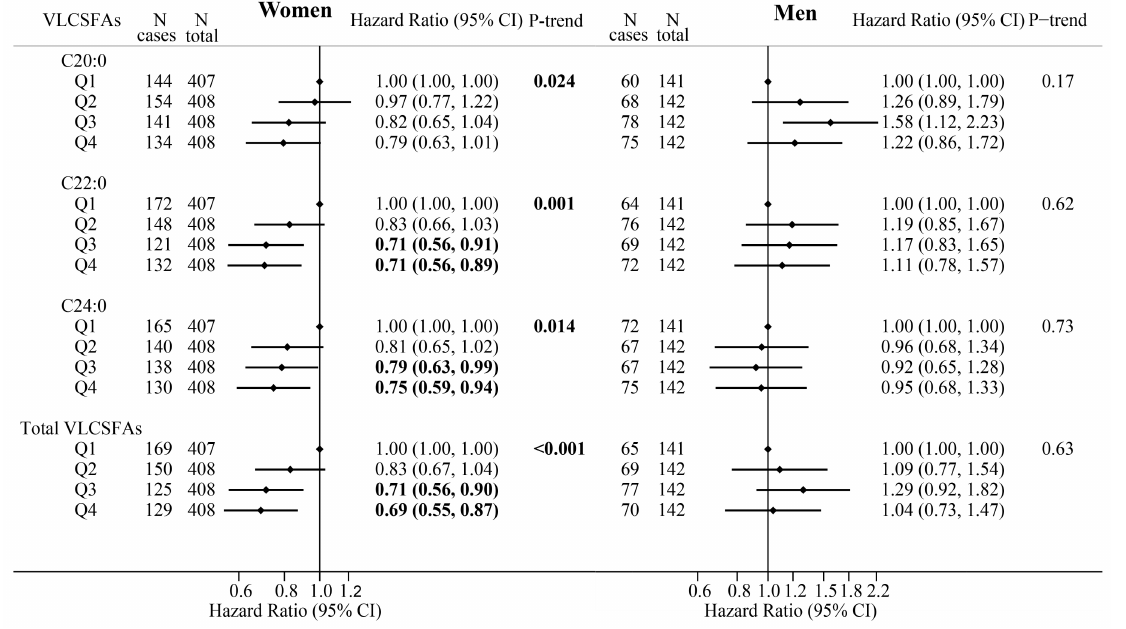
Figure 1. The adjusted hazard ratios (HRs) and 95% confidence intervals (CIs) for carotid artery plaques according to quartiles of the erythrocyte VLCSFA proportions in participants stratified by sex (Women / Men). Abbreviations: Q, quartiles; VLCSFA, very-long-chain saturated fatty